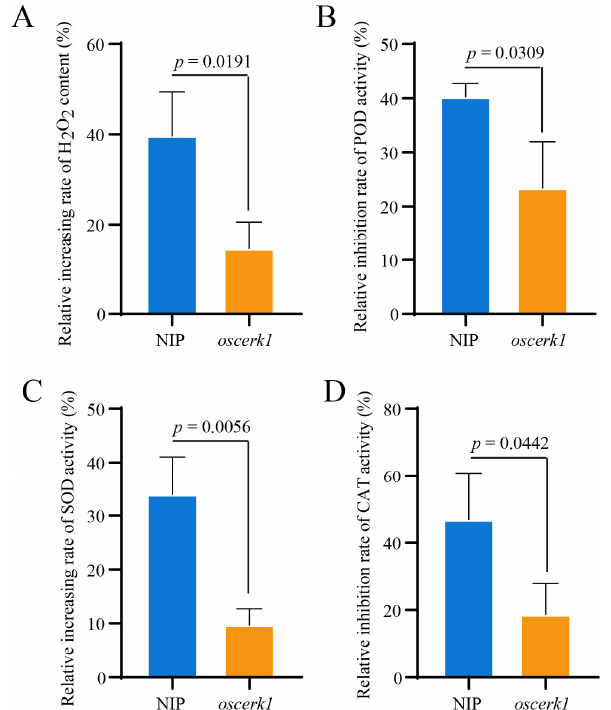
Figure 3. Physiological and biochemical changes of the oscerk1 mutant upon CuO NPs treatment. ( A ) The relative increasing rates of H 2 O 2 content in the oscerk1 mutant and its wild-type Nipponbare (NIP) treated with CuO NPs for 14 days. The changes of POD activities ( B ), SOD activities ( C ), and